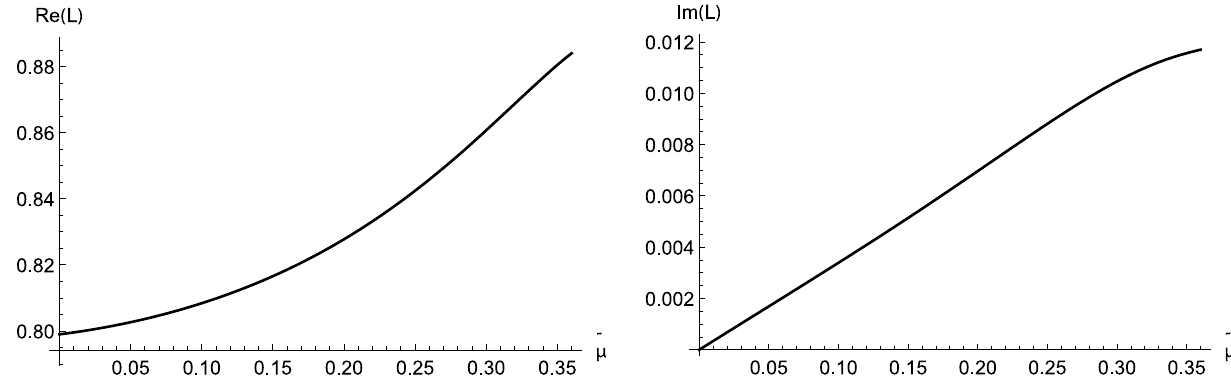
Fig. 8 Real (left panel) and imaginary (right panel) parts of the Polyakov loop (1) as function of ˜ μ (imaginary chemical potential). The (small) imaginary part results from the y -dependence shown in Fig.5. The parameters are g = 4, N f =